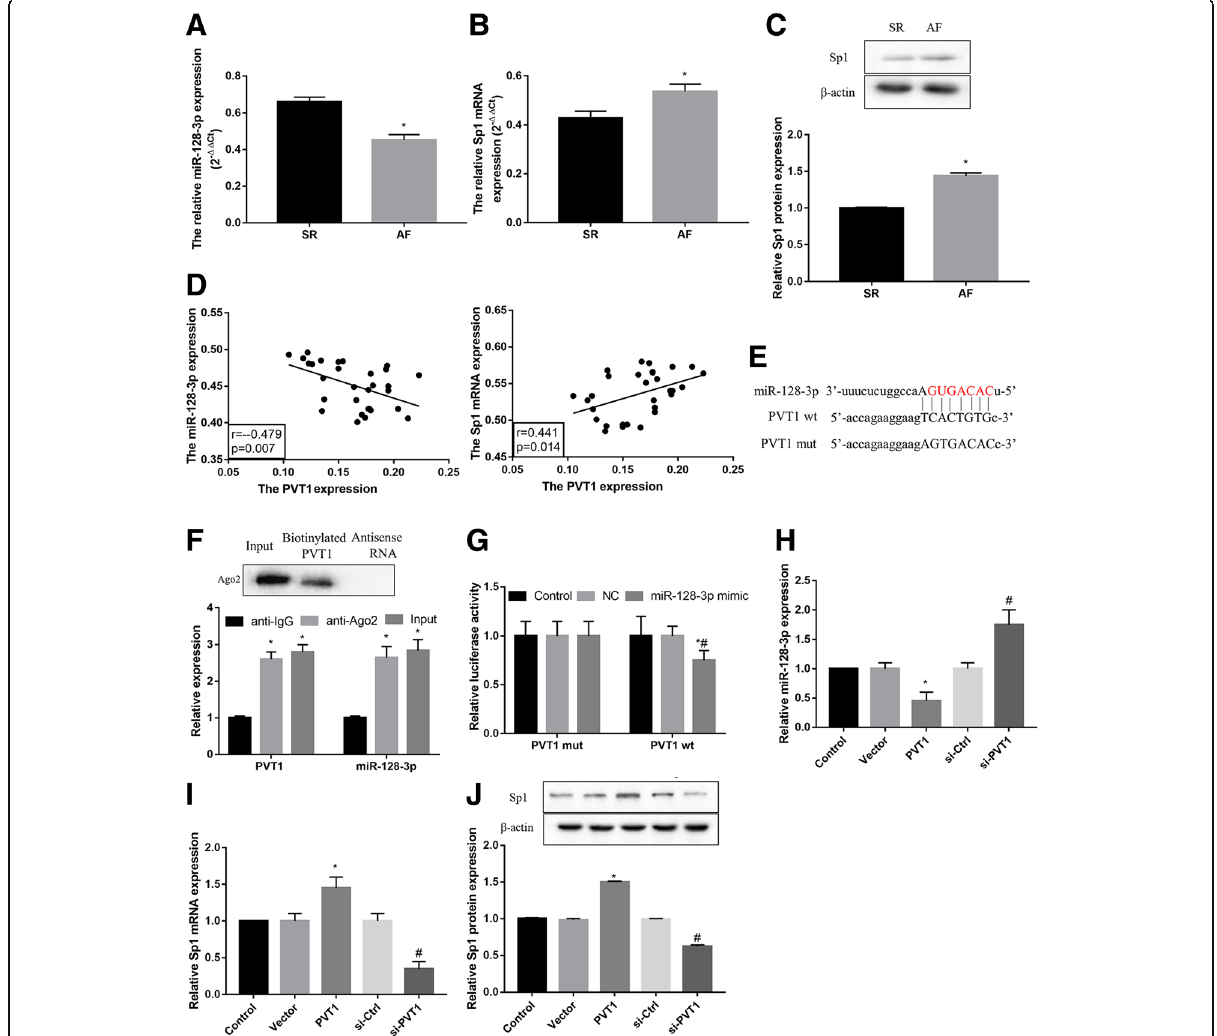
Fig. 3 PVT1 acts as s sponge for miR-128-3p to facilitate Sp1 expression. a Compared with the SR group, the AF group showed significantly decreased expression of miR-128-3p ( a ) and increased mRNA ( b ) and protein ( c ) expression of Sp1 in human atrial muscle tissues. β -actin served as the loading control. d PVT1 expression was negatively correlated with miR-128-3p expression, whereas positively correlated with Sp1 mRNA expression in human atrial muscle tissues from AF patients. e The predicted binding sites between PVT1 and miR-128-3p (DIANA TOOLS-LncBase v.2). f Relative PVT1 and miR-128-3p expression presented as fold enrichment in Ago2 relative to normal IgG immunoprecipitates. RIP assays disclosed that PVT1 and miR-128-3p expressions were substantially enriched by Ago2 antibody compared with control IgG antibody. g Luciferase activity was measured in fibroblasts co-transfected with mimic NC or miR-128-3p mimic and PVT1-wt or PVT1-mut reporter at 48 h after transfection. PVT1 interacted directly with miR-128-3p. In addition, PVT1 overexpression inhibited miR-128-3p expression ( h ), elevated mRNA ( i ) and protein ( j ) levels of Sp1 in fibroblasts, whereas PVT1 knockdown exerted the opposite effect. a - c * P < 0.05 vs. SR; ( f ) * P < 0.05 vs. anti-IgG; ( g ) * P < 0.05 vs. PVT1 wt + mimic NC, # P < 0.05 vs. PVT1 wt + control; h - j * P < 0.05 vs. vector, # P < 0.05 vs. si-Ctrl. Data are presented as mean ± SD. SR, sinus rhythm; AF, atrial fibrillation; PVT1, plasmacytoma variant translocation 1; Sp1, specificity protein